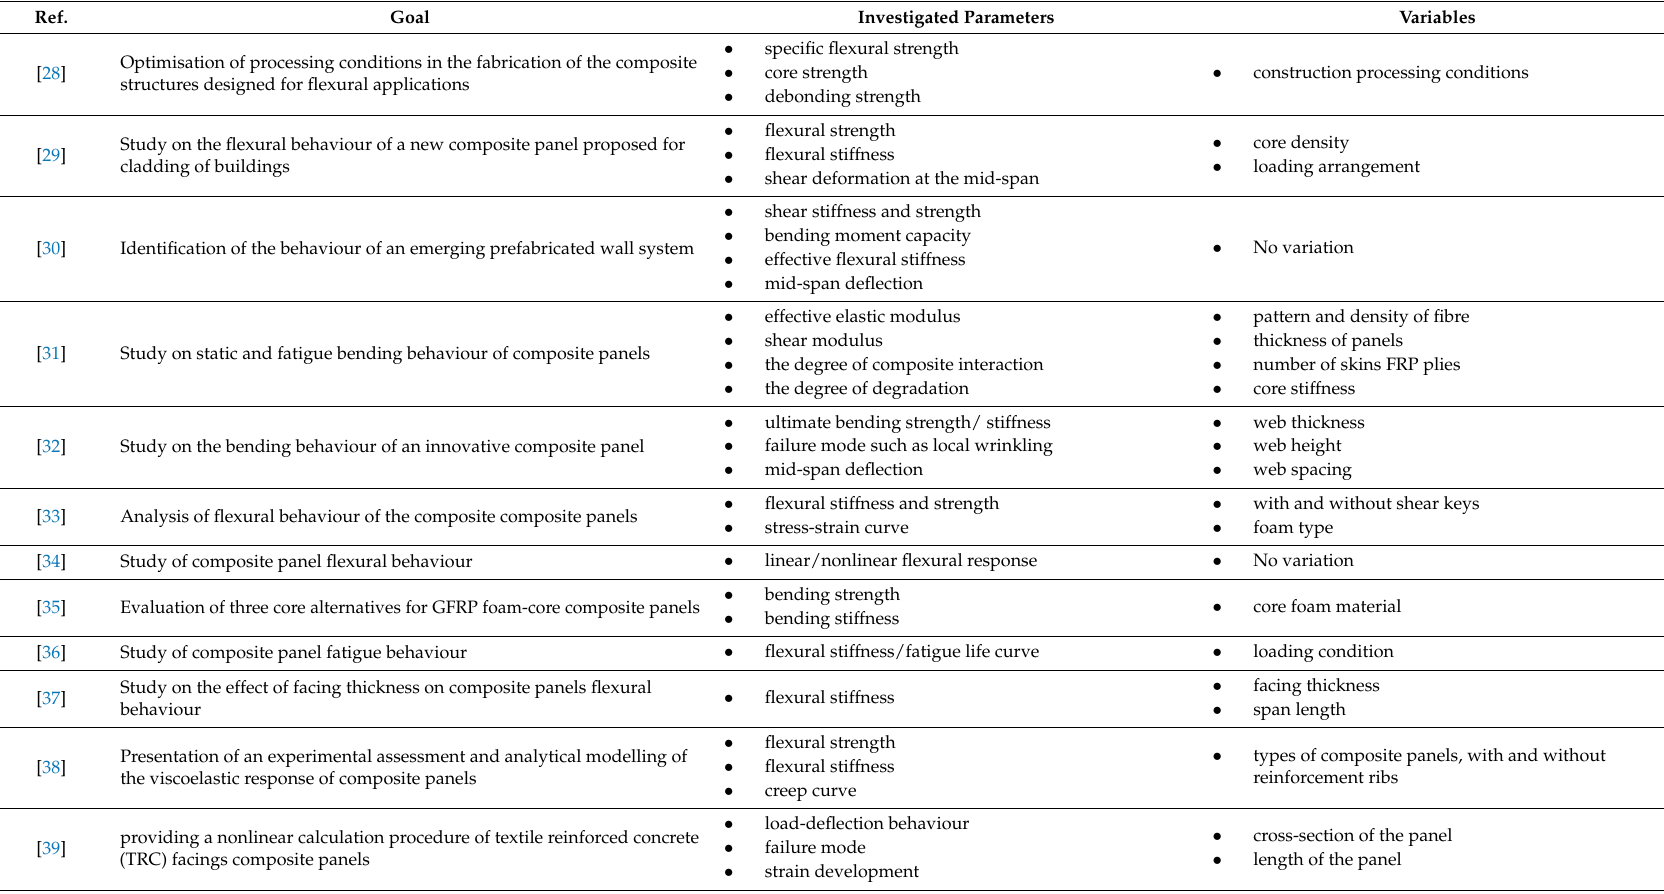
Table 2. Summary of the critical literature of bending and shear behaviour of PU foam-filled composite panels.